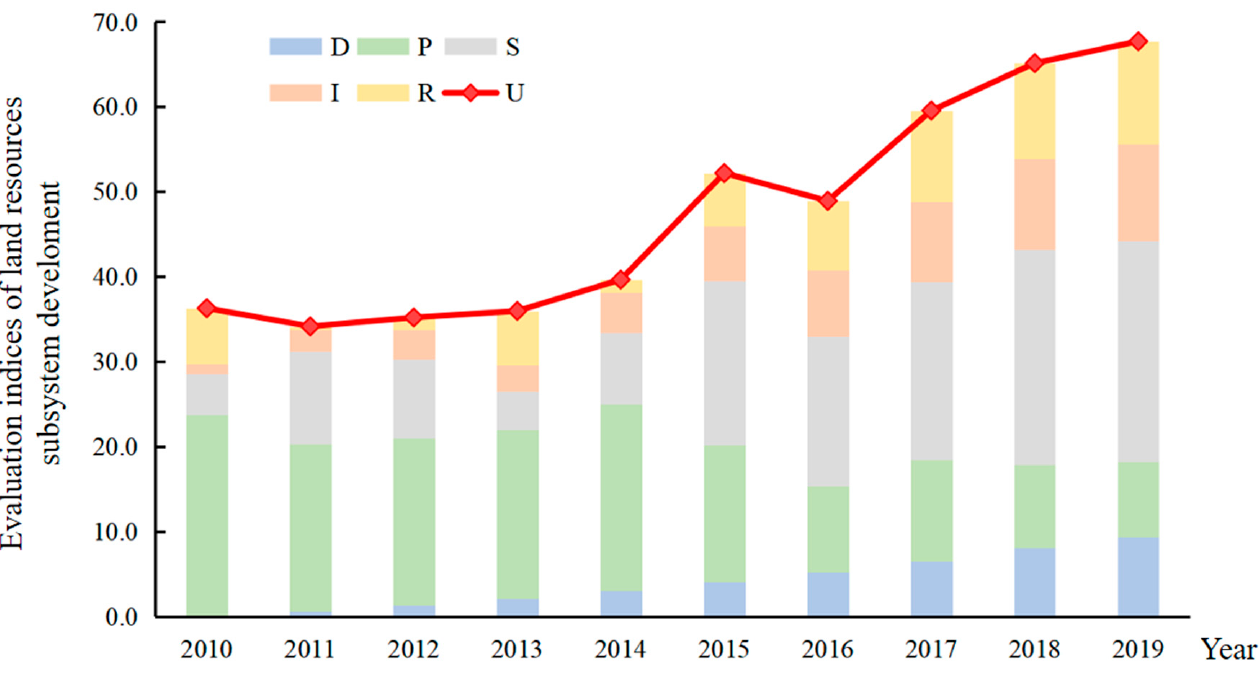
Figure 6. Trends of the development level of the land resources.